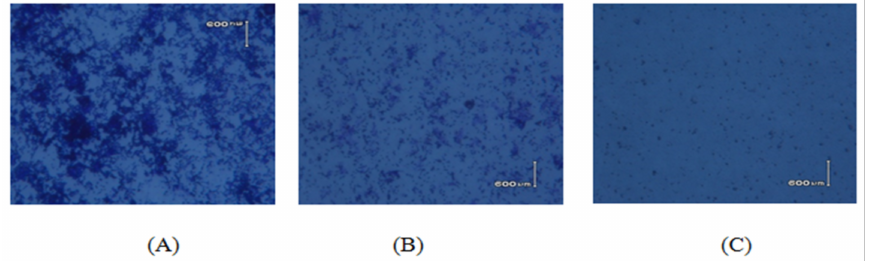
Figure 2. Phase contrast microscopic view of inhibition of E. coli biofilm by extracts of leaves and fruit of A. marmelos . ( A ) Negative control E. coli biofilm. ( B ) Biofilm treated with leaves extract ( C ) Biofilm treated with fruit extract.